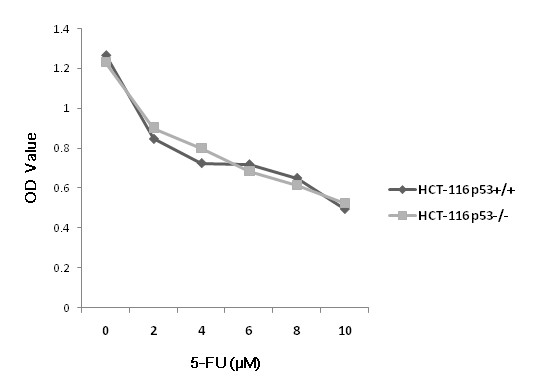
5-FU induced cytotoxicity in HCT-116p53+/+ and HCT-116p53-/- cell lines in a dose-dependent manner at 48 h (p < 0.001).